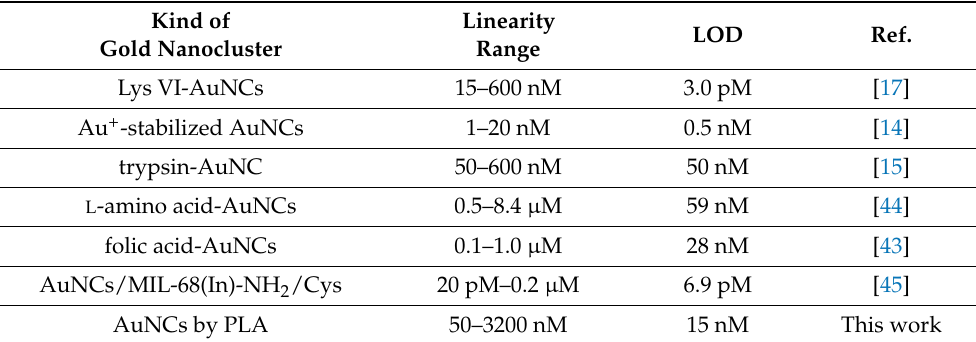
Table 3. Comparison of sensitivity, linearity constant (R 2 ), limit of detection (LOD) and linearity range (C max ) in the PL quenching of the AuNCs reported in the literature, after interaction with the Hg 2+